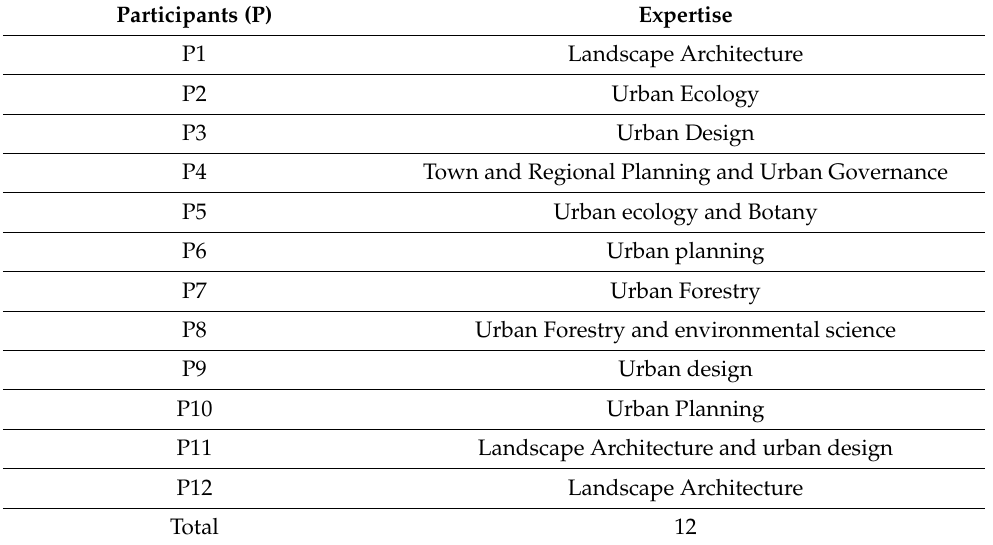
Table 1. List of participants and their expertise.